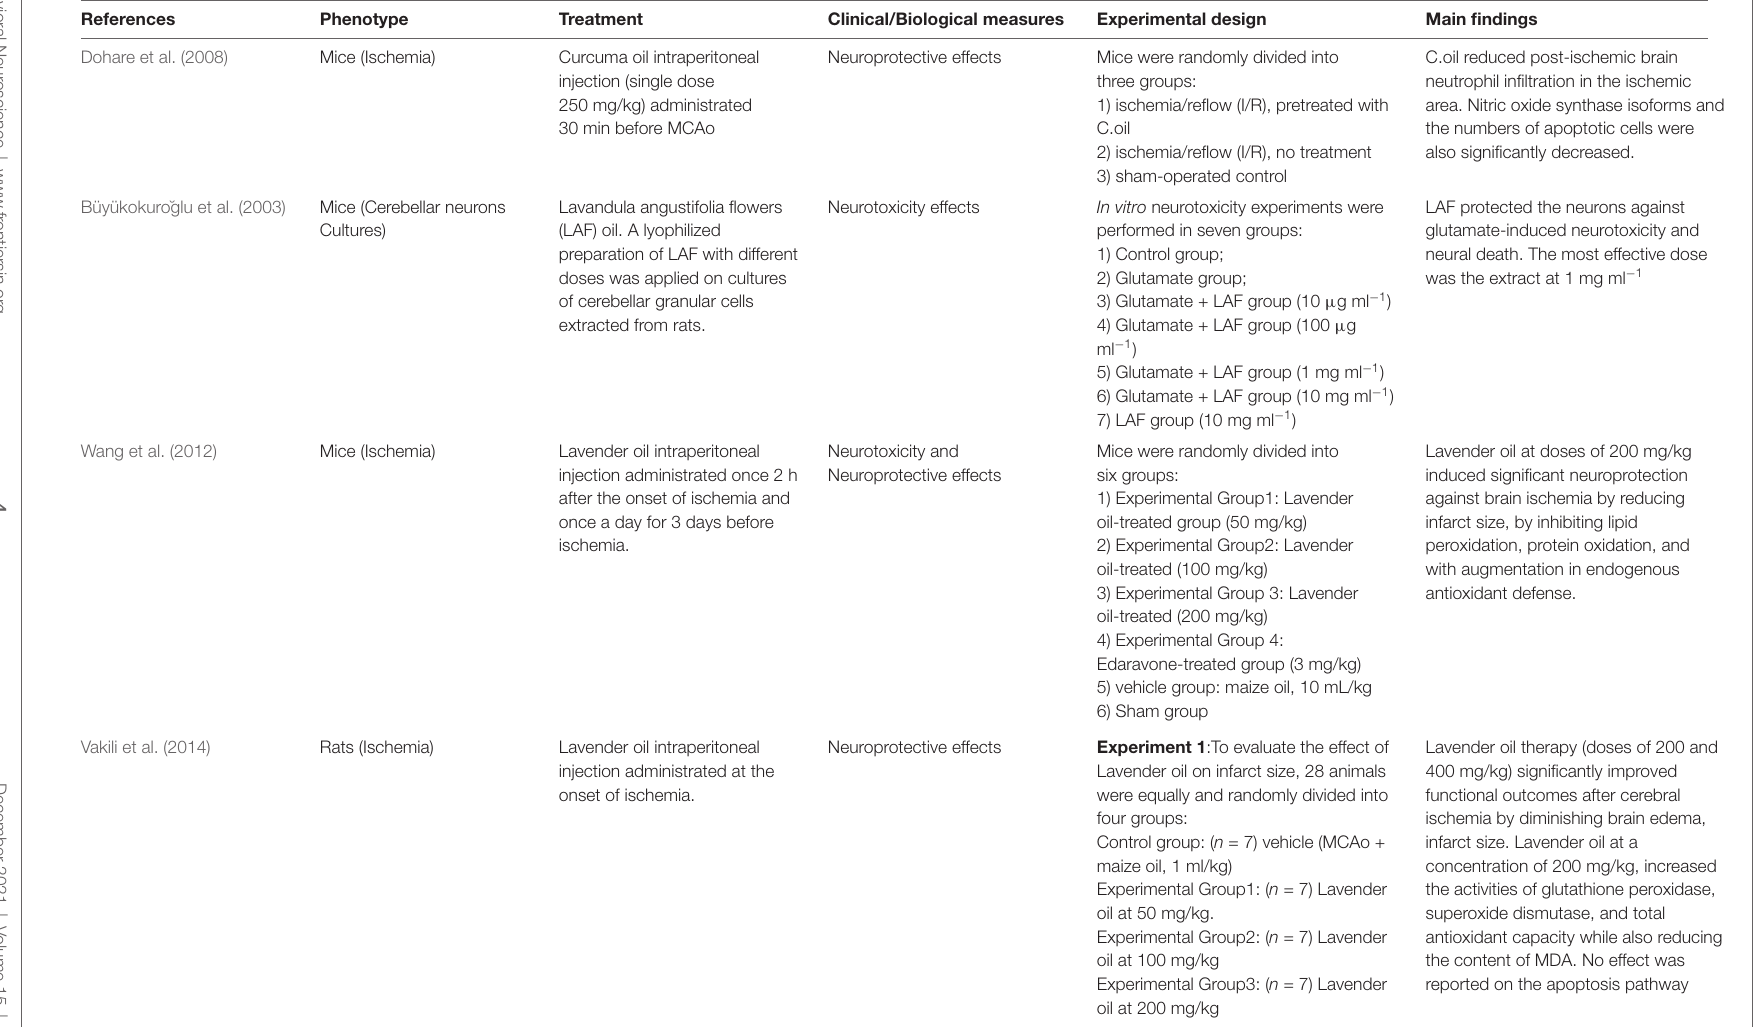
TABLE 1 | Main findings of preclinical studies assessing the neuroprotection by essential oils against experimental cerebral